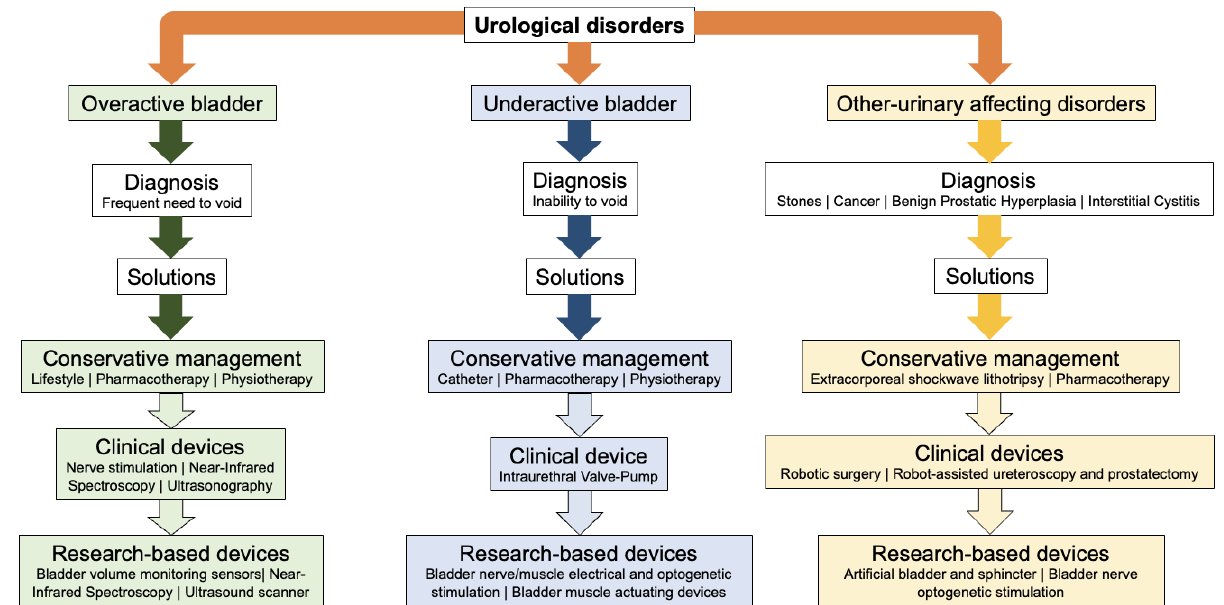
Figure 2. A summary of steps that are considered for each urological disorder in this study.